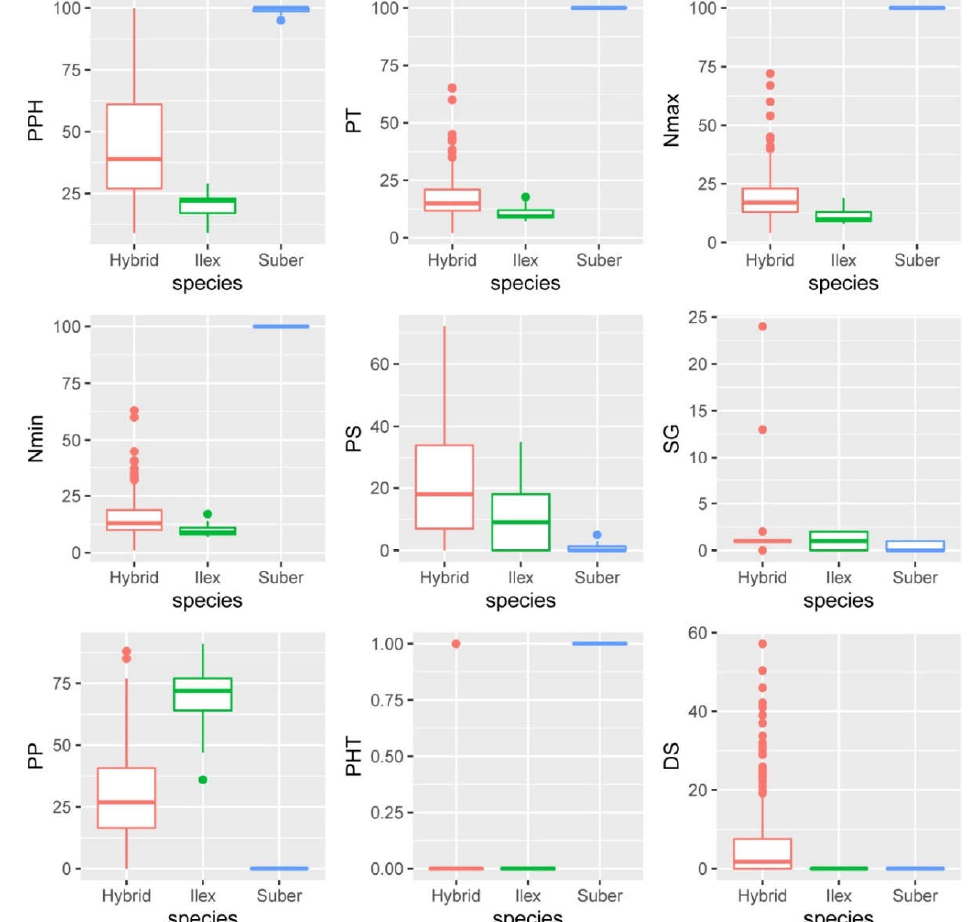
Figure 3. Boxplots of Q. ilex , Q. suber and the hybrids for all the variables related to outer bark anatomy described in Table